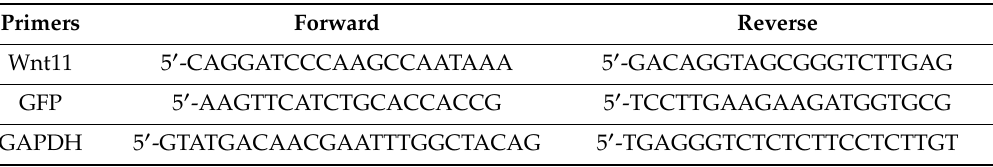
Table 1. Primers used in this